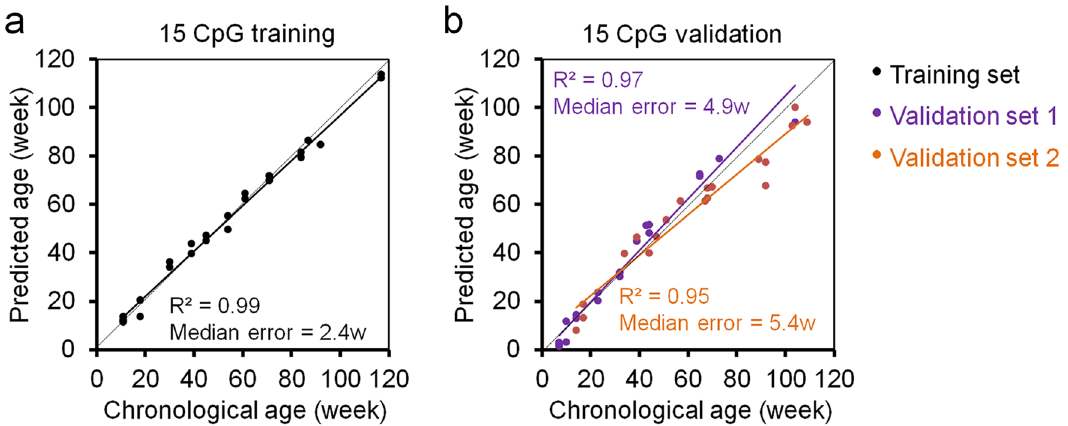
Figure 1. Epigenetic age predictions for pyrosequencing data (15 CpG lasso regression model). ( a ) Multivariable machine learning (Lasso regression) age-predictor based on DNAm levels at 15 CpGs in the genes Prima1 , Hsf4 , Kcns1, Gm9312, Gm7325. Pyrosequencing was performed for 24 C57BL/6 mice (training set) as described before 17 . ( b ) Age predictions with the same model in two independent validation sets: 21 C57BL/6 mice from the University of Ulm and 19 C57BL/6 mice from the University of Groningen (validation sets 1 and 2, respectively). Coefficients of determination (R 2 ) of DNAm versus chronological age and median errors (weeks) are